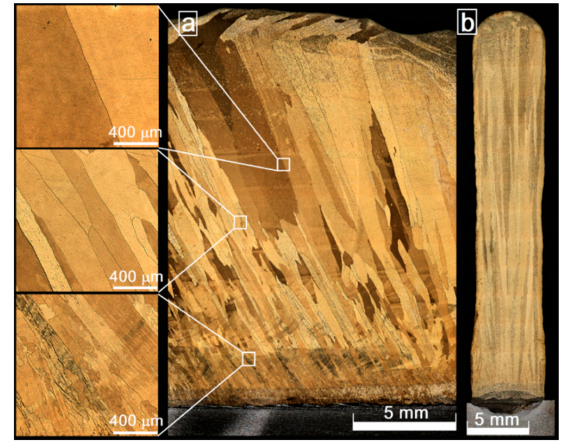
Figure 3. The microstructures of as-grown Cu-7.5wt.%Al bronze as viewed in sections parallel to the wall sides ( a ) and perpendicular to the table motion direction ( b ).